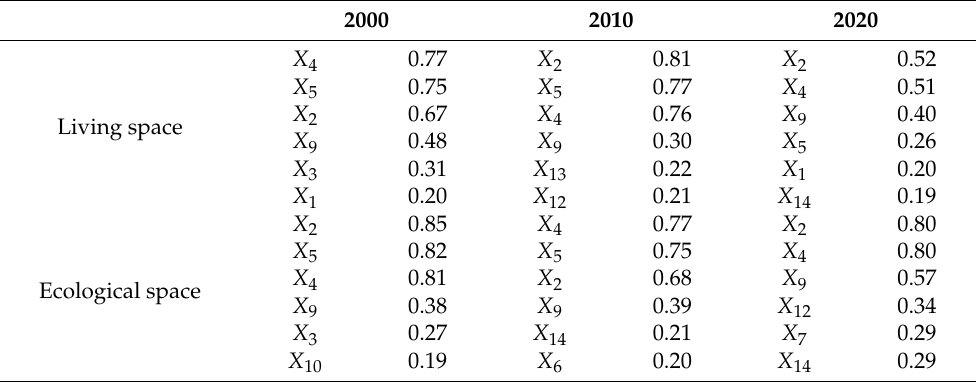
Table 7. Driving factors of territorial spatial evolution in the Yangtze River Economic Belt, 2000–2020 (Top